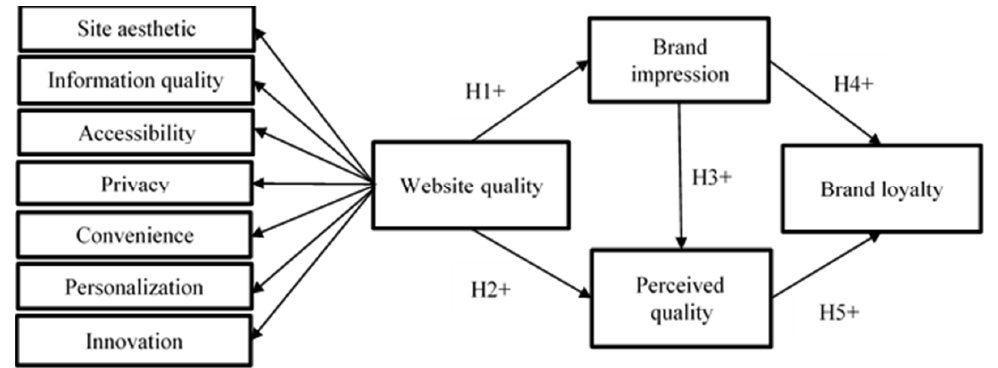
Fig. 1. Proposed research